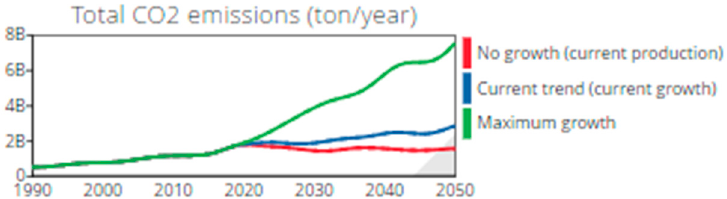
Figure 9. Extreme condition test results for total CO 2 emissions. The coloured lines on the graph represents (1) gross demand growth rate set to 0% (no growth) for black coal, brown coal, gas and oil, (2) gross demand growth rate set to (0%, − 8%, 22.7%, 2%) (current trend) for black coal, brown coal, gas and oil respectively, (3) gross demand growth rate set to (10.3%, 13.8%, 27.3%, 7.5%) (maximum) for black coal, brown coal, gas and oil respectively.